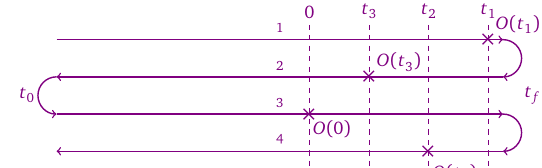
) O ( t ) O ( 0 ) O ( t 1 3